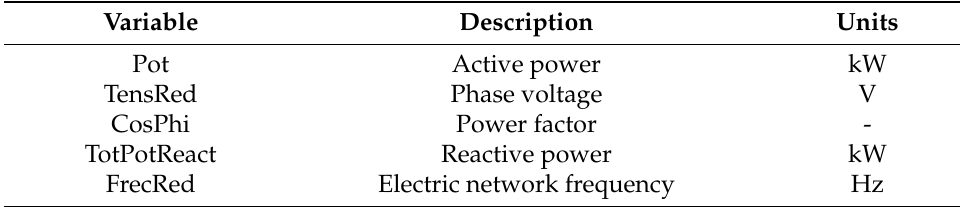
Table 3. Electrical variables.